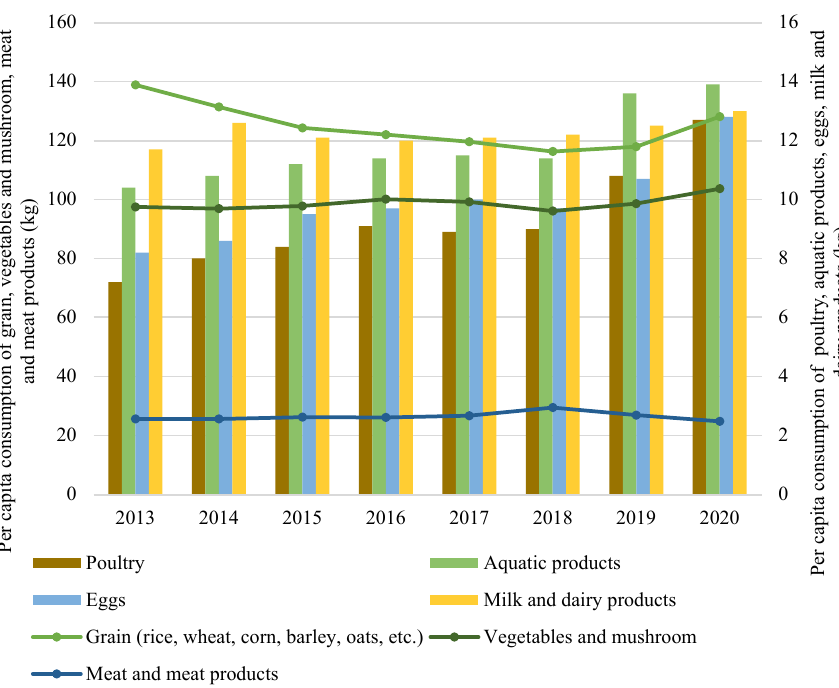
Figure 3. China’s per capita consumption of major foods in 2013–2020. Data source: China Statistical Yearbook.